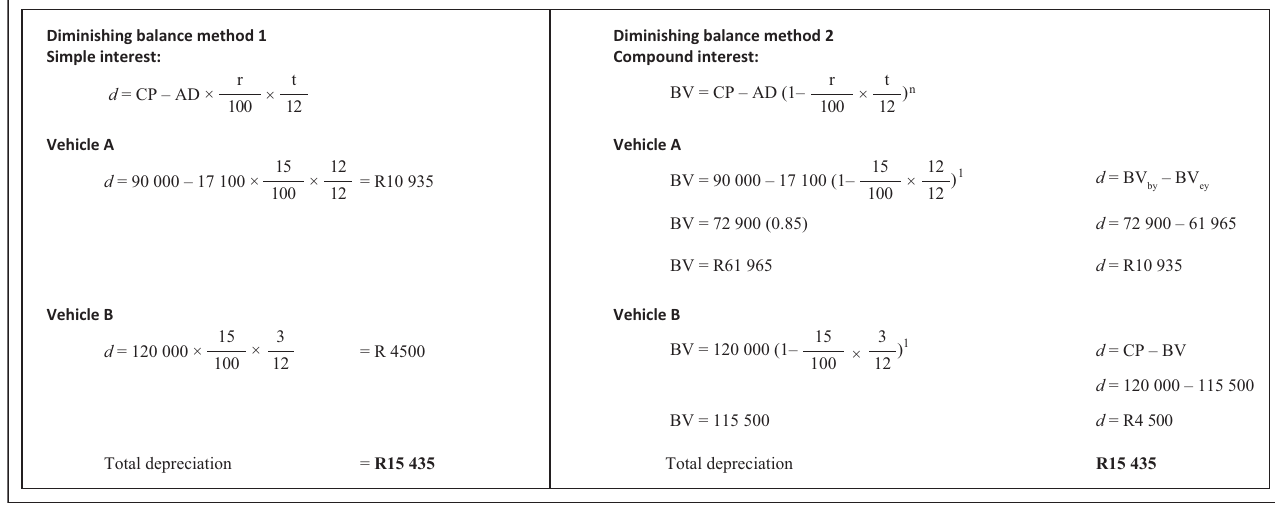
FIGURE 24: Diminishing balance method – Simple and compound interest.